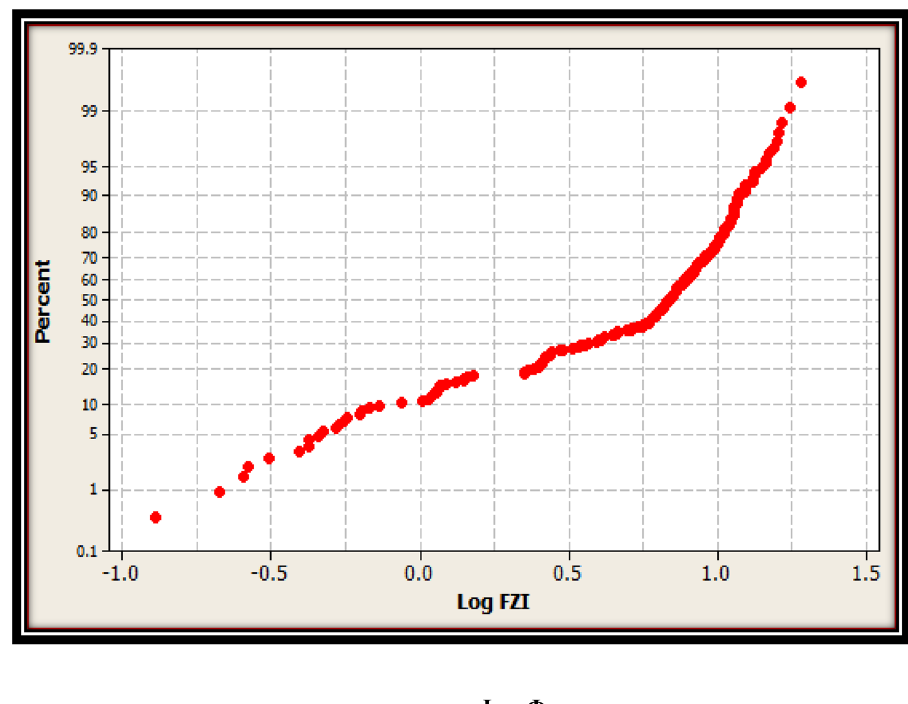
Fig. 7 Cross-plot of log- normalized porosity versus log reservoir quality index of core data